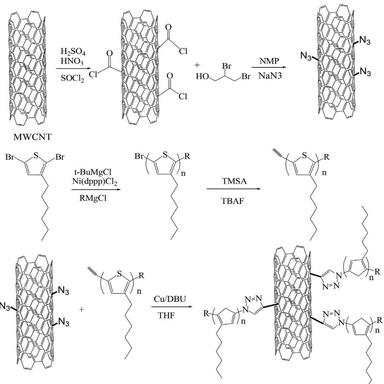
Synthesis routine for the preparation of P3HT-MWCNT by click chemistry.